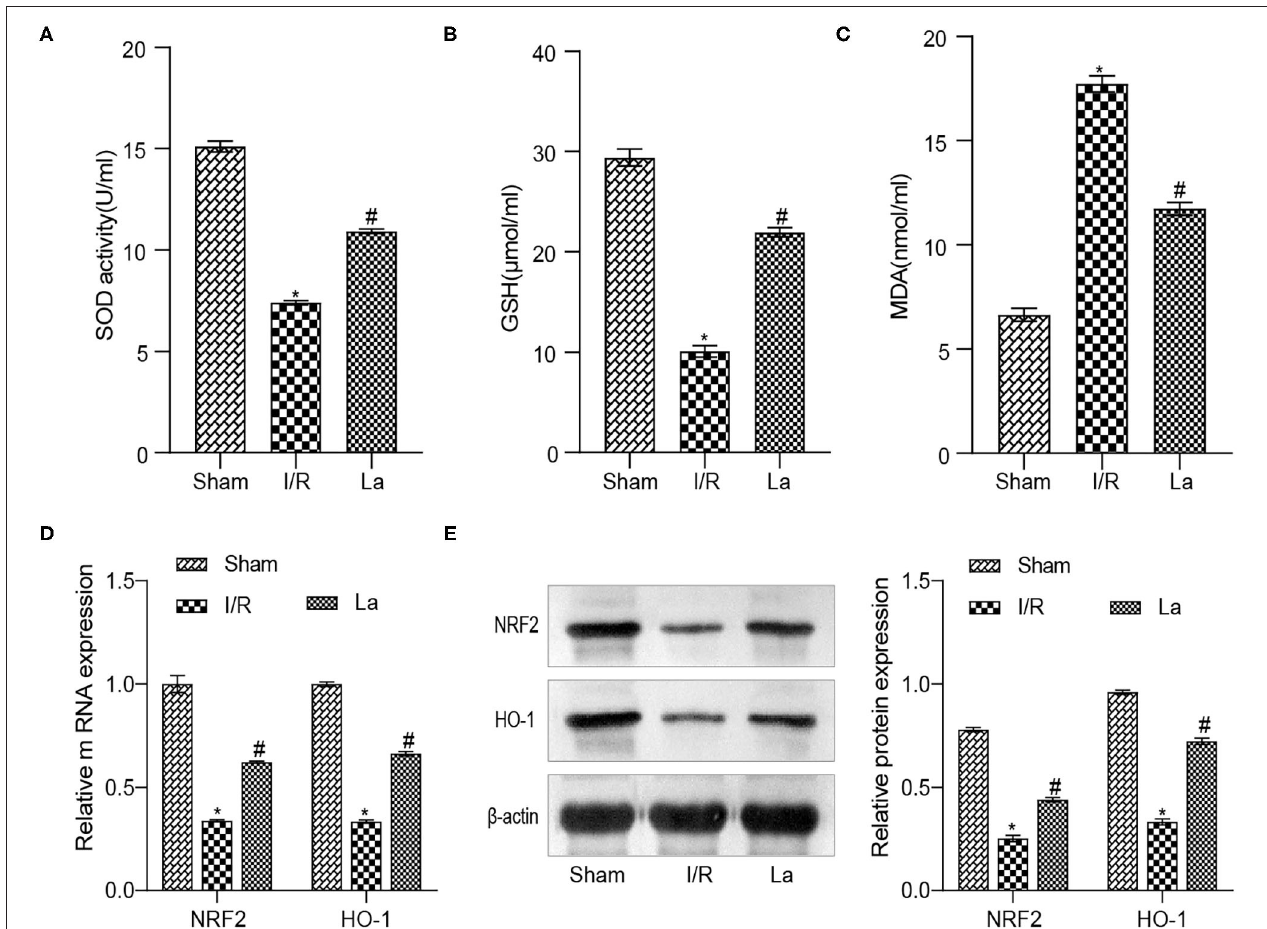
FIGURE 2 | Lactobacillus acidophilus ATCC 4356 reduced the level of oxidative stress in mice with renal ischemia–reperfusion injury (IRI). (A) ATCC 4356 elevated superoxide dismutase (SOD) concentration in ischemia/reperfusion (I/R) mice. (B) ATCC 4356 promoted glutathione (GSH) expression in I/R mice. (C) ATCC 4356 decreased malondialdehyde (MDA) levels in I/R mice. (D) ATCC 4356 promoted the expression of nuclear factor-related factor 2 (Nrf2) and heme oxygenase 1 (HO-1) mRNA in I/R mice. (E) ATCC 4356 increased Nrf2 and HO-1 protein expression in I/R mice. All data are expressed as mean ± standard deviation. All experiments were repeated three times independently. Statistical significance was calculated using one-way analysis of variance. * p < 0.05 vs. Sham, # p < 0.05 vs.